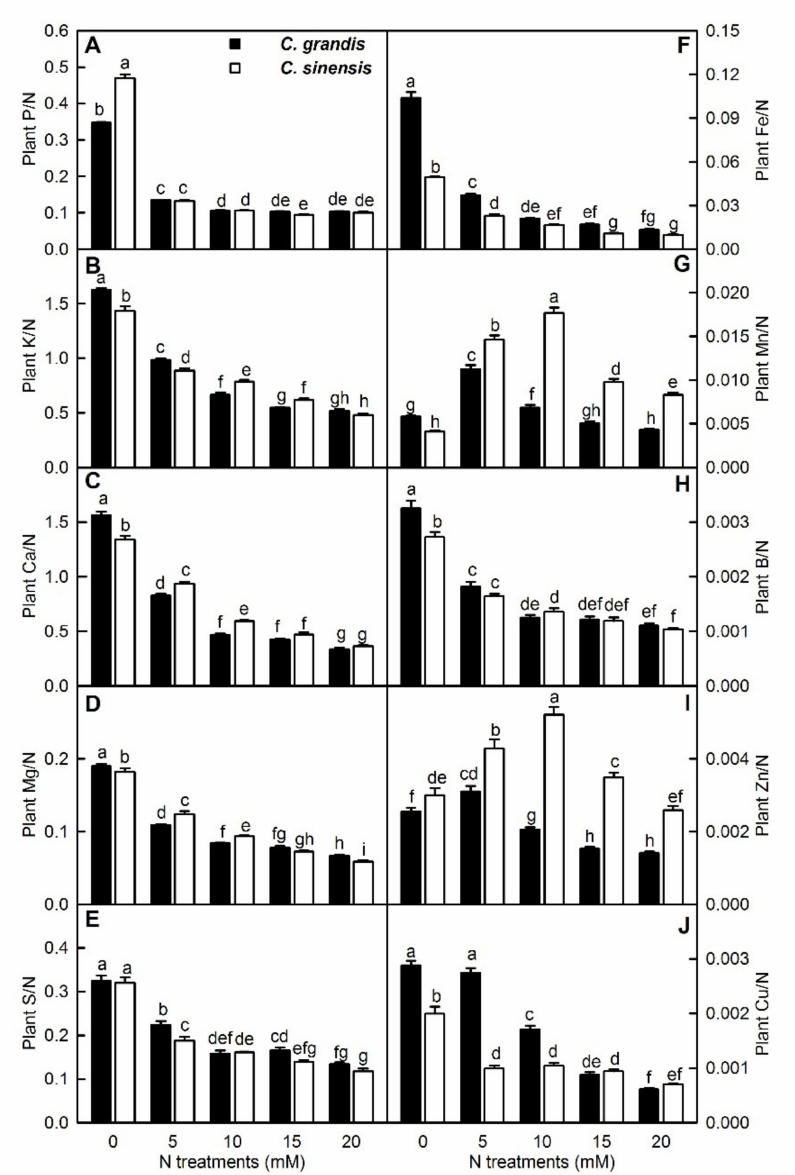
Figure 5. The effects of N supply on mean ( ± SE, n = 4) ratios of P ( A ), K ( B ), Ca ( C ), Mg ( D ), S ( E ), Fe ( F ), Mn ( G ), B ( H ), Zn ( I ) and Cu ( J ) uptake per plant to N uptake per plant. PCCs were calculated for whole plant DW, plant total element content (element uptake per plant) and the ratios of plant total element content to total N content (Figure S4). Whole- plant DW was significantly and positively related to plant total N, B, S, Mg or K content ( r > 0.8866), and displayed an upward trend with increasing plant total Cu, Mn, Ca, Zn or P content; but it was significantly and negatively related to plant total P/N, Mg/N, Ca/N, K/N, S/N or B/N ratio ( r < − 0.7809), and displayed a downward trend with increasing plant total Fe/N, Cu/N or Zn/N ratio. A positive and significant relationship existed between any two parameters of plant total N, B, S, Mg and K contents ( r > 0.6366) or plant total P/N, Mg/N, Ca/N, K/N, S/N and B/N ratios ( r >